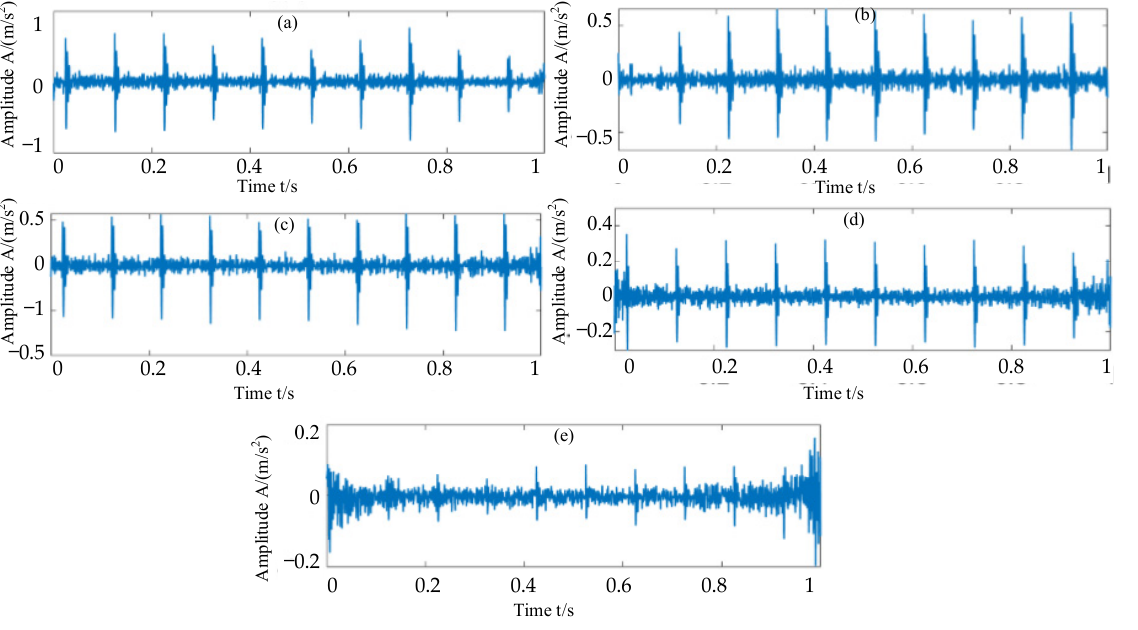
Figure 6. Hankel matrix transformation test. ( a ) 200 lines; ( b ) 400 lines; ( c ) 600 lines; ( d ) 800 lines; and ( e ) 1000 lines.